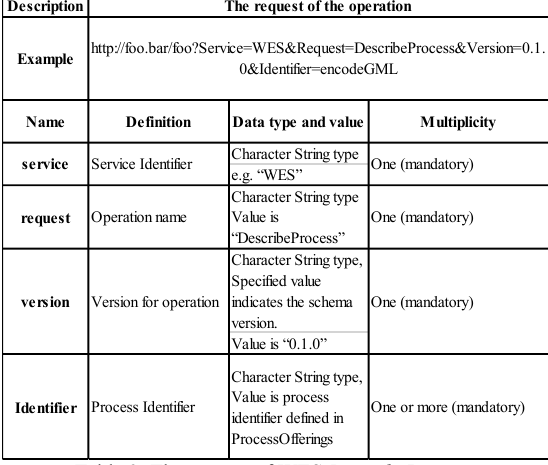
Table 3: The request of WES DescribeProcess.